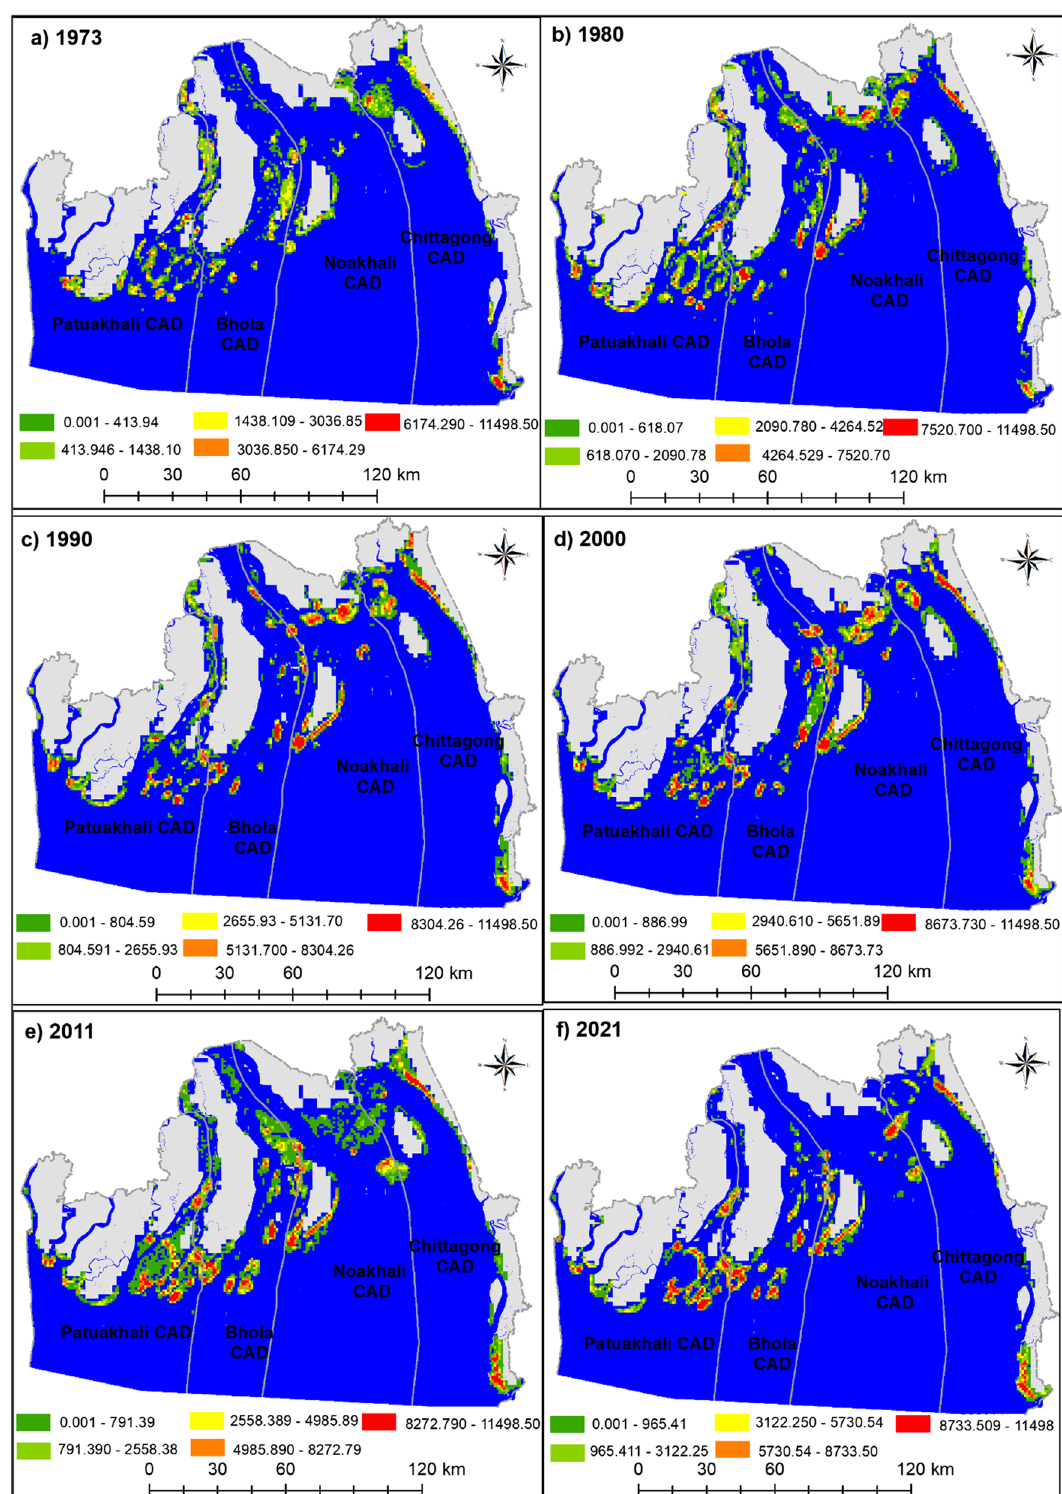
Fig. 15 Spatio-temporal representation of carbon stock in the coast of Bangladesh from 1962 to